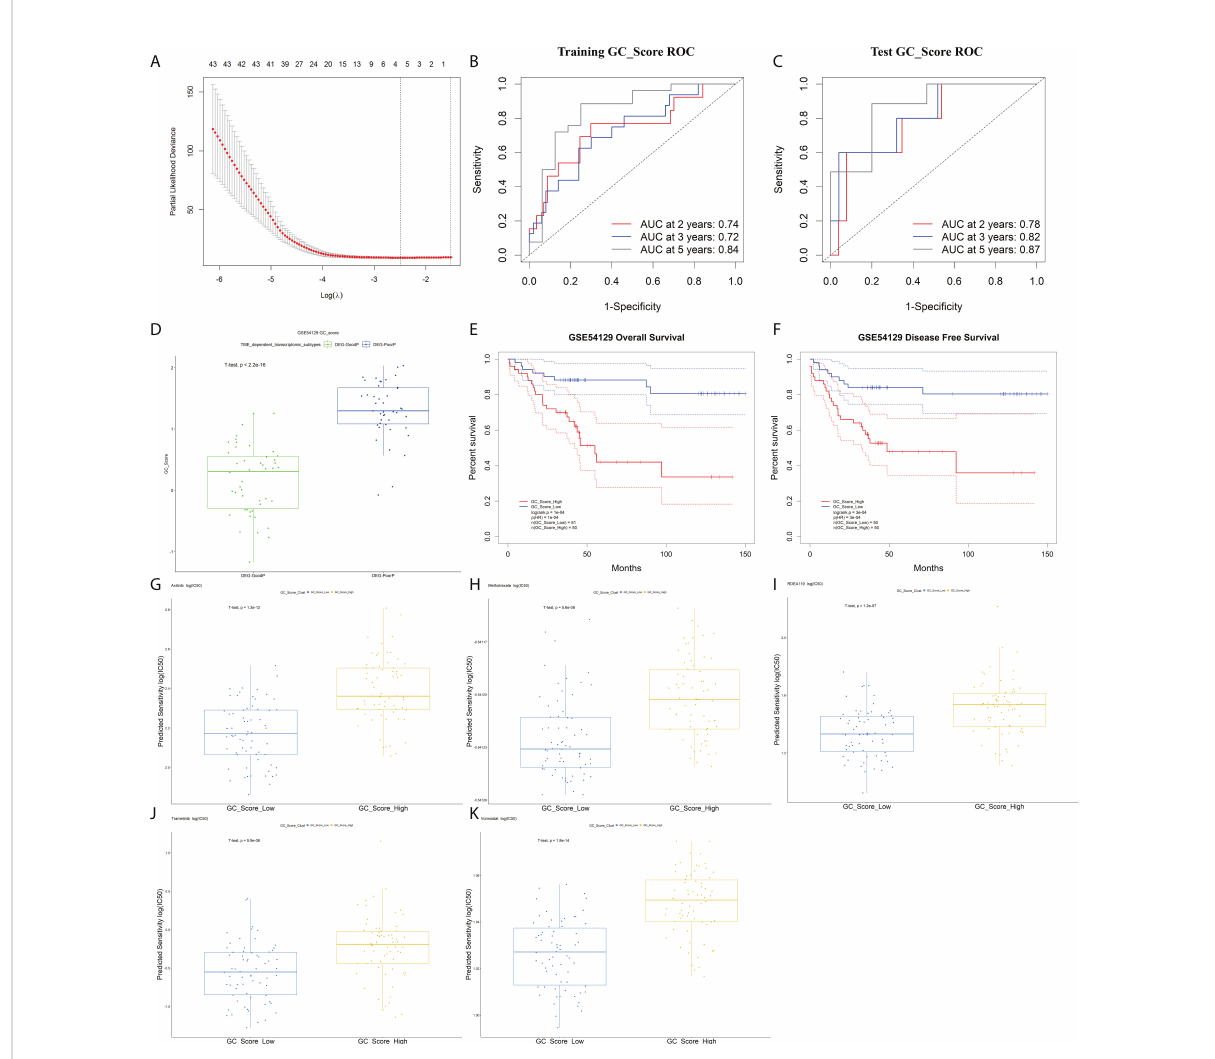
FIGURE 5 The GC_Score model and its prognostic signi fi cance. (A) Several cell types were involved in the LASSO model. (B, C) The GC_Score was measured by time-dependent receiver operating characteristic (ROC) curves in the training set and the test set. (D) The boxplot of GC_Score in DEG-GoodP and DEG-PoorP subtypes. The thick line represented the median value. The bottom and top of the boxes were the 25th and 75th percentiles (interquartile range). (E, F) Survival impact of the GC_Score, Kaplan – Meier curves for overall survival (OS) and disease-free survival (DFS) in the GSE54129 cohort. (G – K) The boxplot of drug sensitivity in the GC_Score_Low and the GC_Score_High group. (G) Axitinib, (H) methotrexate, (I) RDEA119, (J) trametinib, (K)